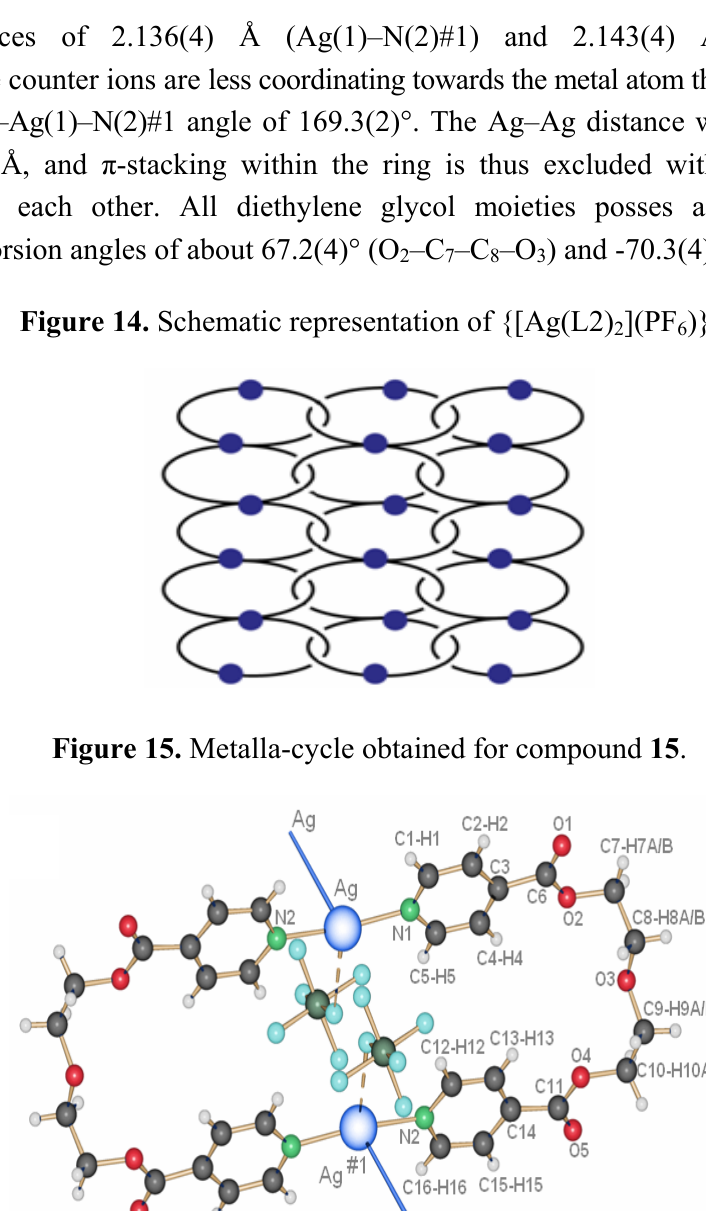
Figure 14. Schematic representation of {[Ag(L2)